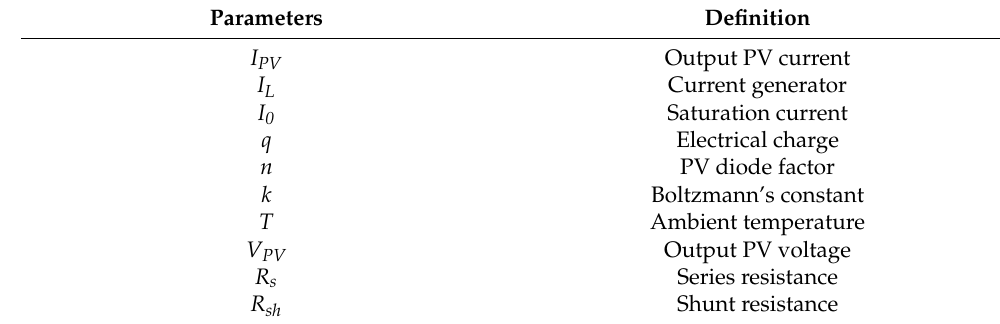
Table 2. Nomenclatures of PV generation.